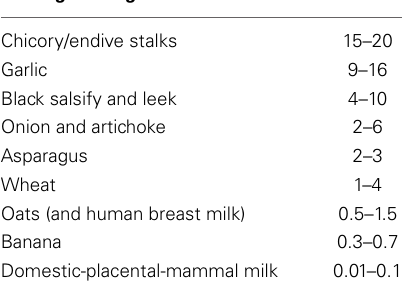
Table 1 | Prebiotics, (a.k.a. soluble fibers) improving growth of probiotic bacteria, as found in dietary components and milk ranked by quantitative